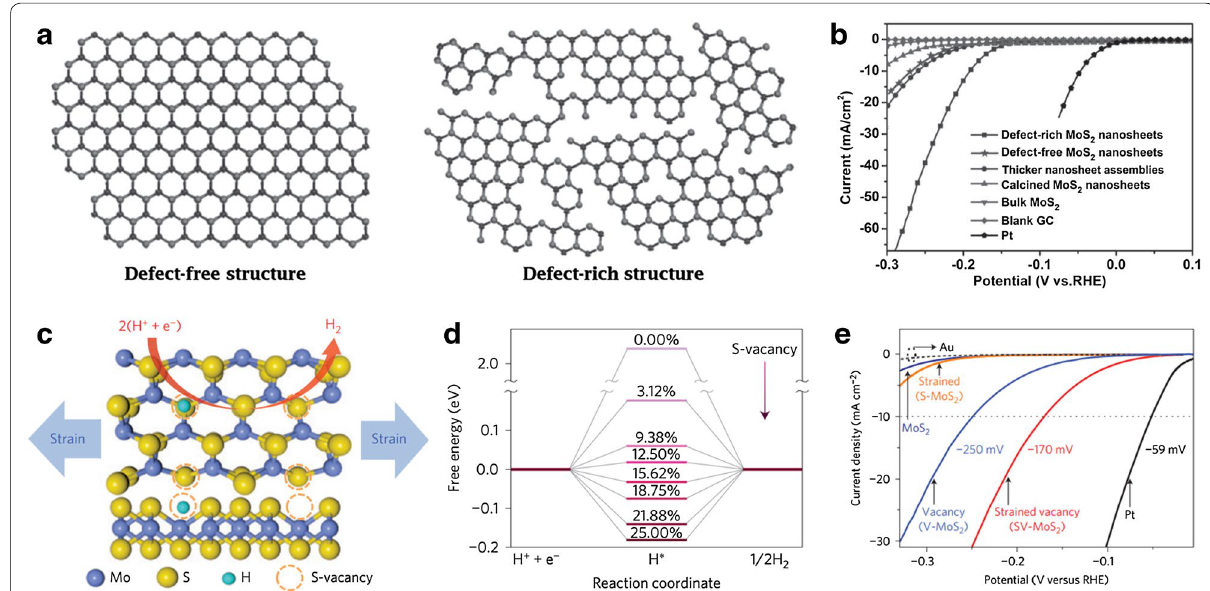
Fig. 8 a Structural models of the defect-free and defect-rich MoS 2 structures. b Polarization curves of the defect-free and defect-rich MoS 2 struc- tures for the HER. c Schematic representations of the top and side views of MoS 2 containing strained S-vacancies on the basal planes. d Free energy versus the HER reaction coordinate for the S-vacancy range of 0–25%. e Polarization curves for the strained, vacancy, and strained vacancy MoS 2 for the HER (Figures reprinted with permission from Refs. [42,